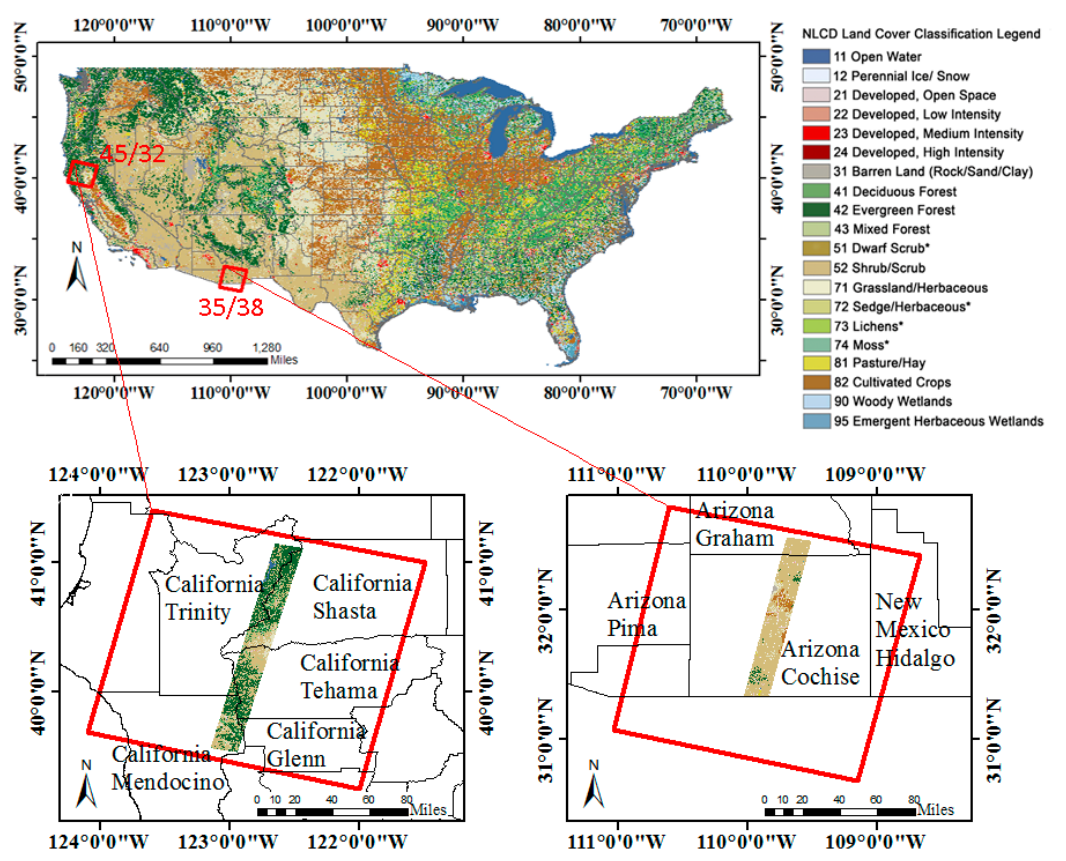
Figure 1. Landsat data areas used in this study based on the NLCD 2011 in the conterminous United States. Table 1. Data acquired in Day of Year (DOY) format for two regions during four seasons. Path/Row: 45/32 Path/Row: 35/38 Seasons Landsat 7 ETM+ Landsat 8 OLI Landsat 7 ETM+ Landsat 8 OLI